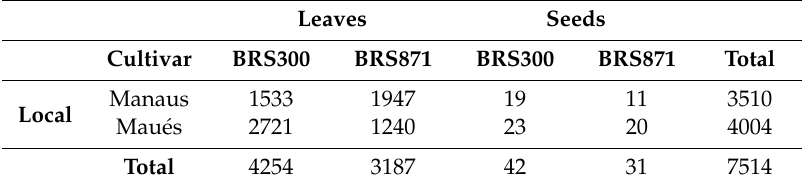
Table 1. Number of endophytic isolates from guarana plants ( Paullinia cupana var. sorbilis ), from the cultivars susceptible BRS300 and resistant BRS871, collected in the municipalities of Manaus and Mau é s AM, Brazil. Leaves